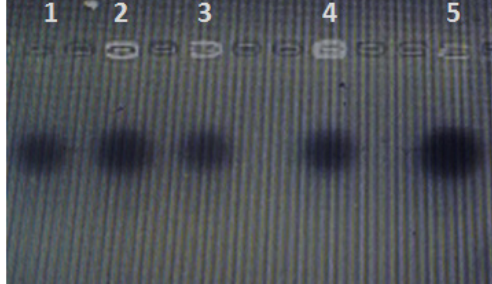
Fig. 1. Plasmid profile of oral bacterial isolates lane 1 positive control E coli Hb101, lane 2-5 oral bacterial isolates E. coli, Klebsilla pneumonia, Staphylococcus aureaus, Cardiobacterium hominis respectively